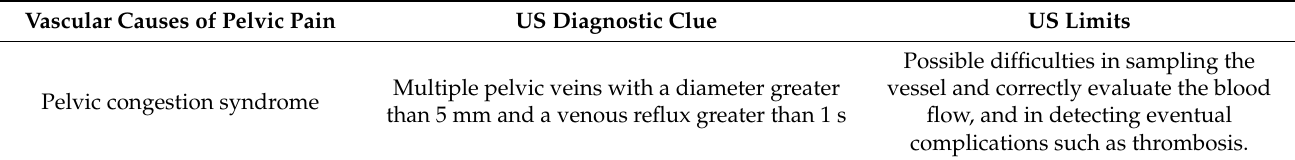
Table 12. Pelvic congestion syndrome US diagnostic clue.